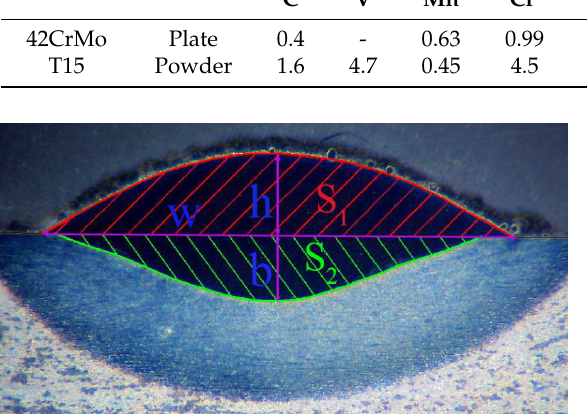
Figure 4. Geometric shape diagrammatic sketch of the cladding layer.